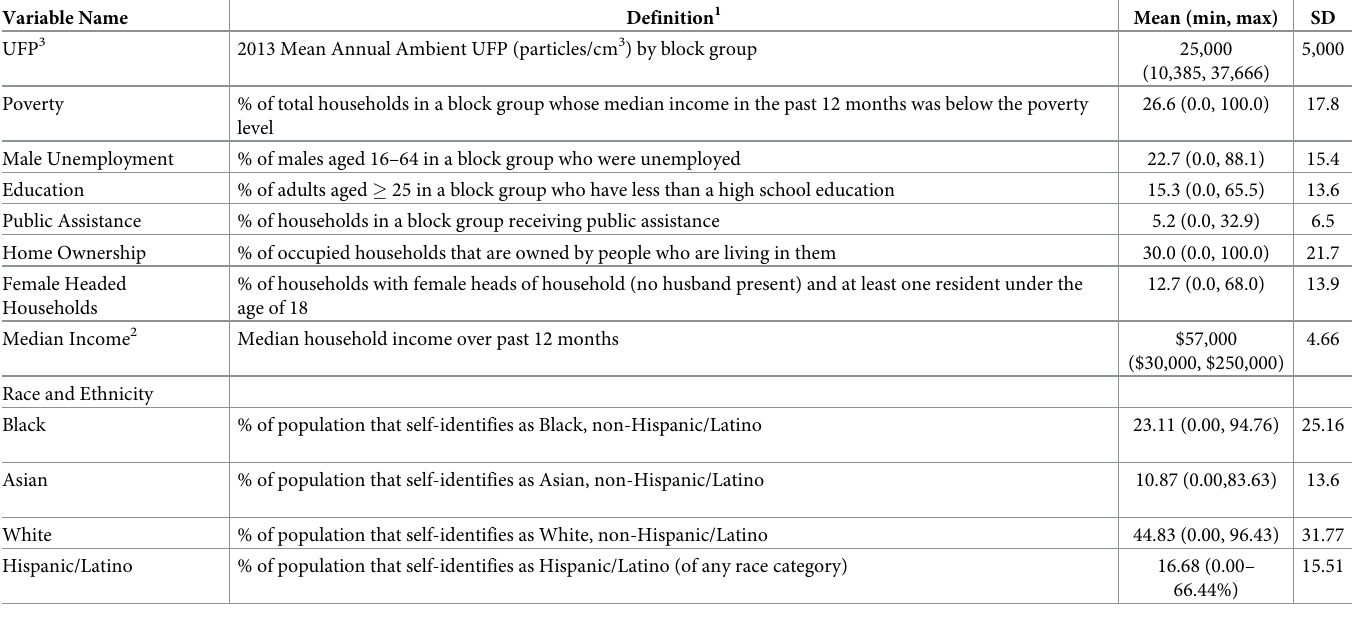
Table 1. List of variables, definitions and descriptive statistics among block groups in the study area (n =